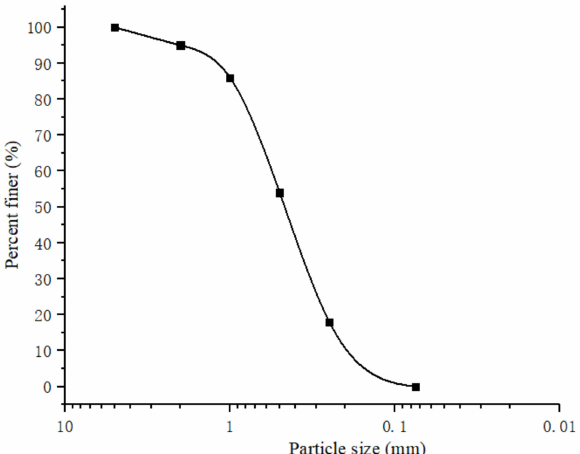
Figure 4. Particle size distribution curve.